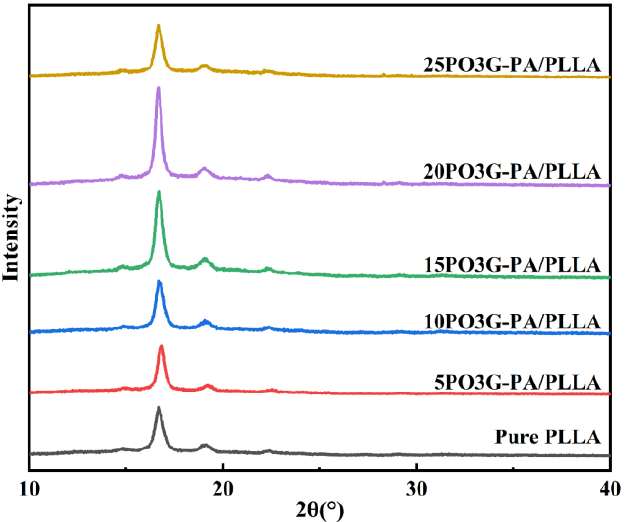
Figure 7. XRD curves of PO3G–PA/PLLA composite films with different ratios.